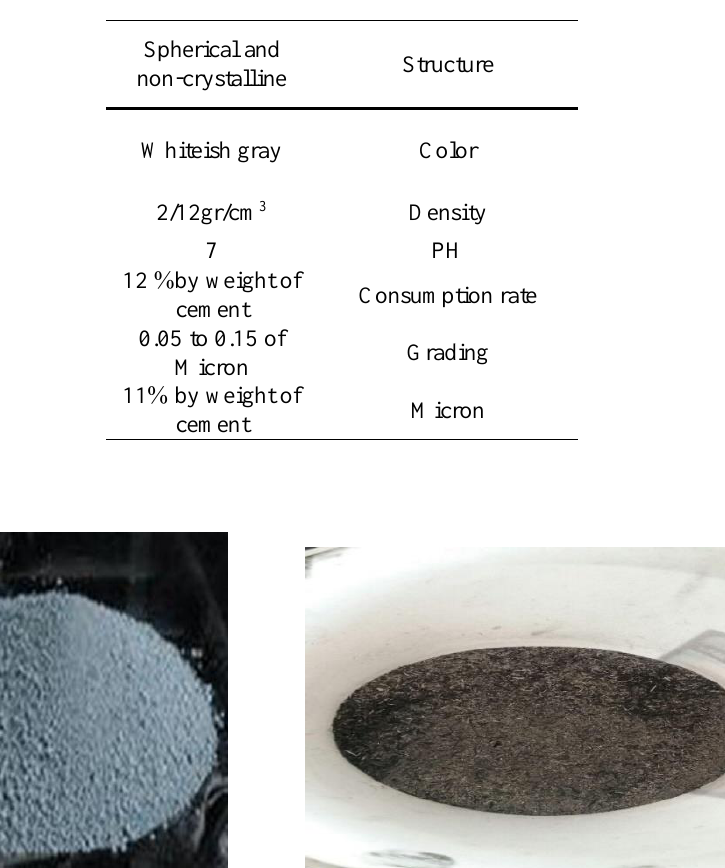
Table 6. Specifications of consumed microsilica.